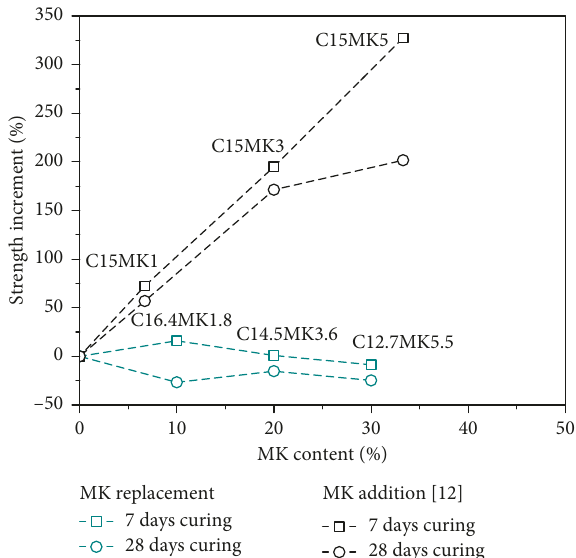
Figure 2: Strength increment ratio of the cement-treated soil with MK replacement and addition.